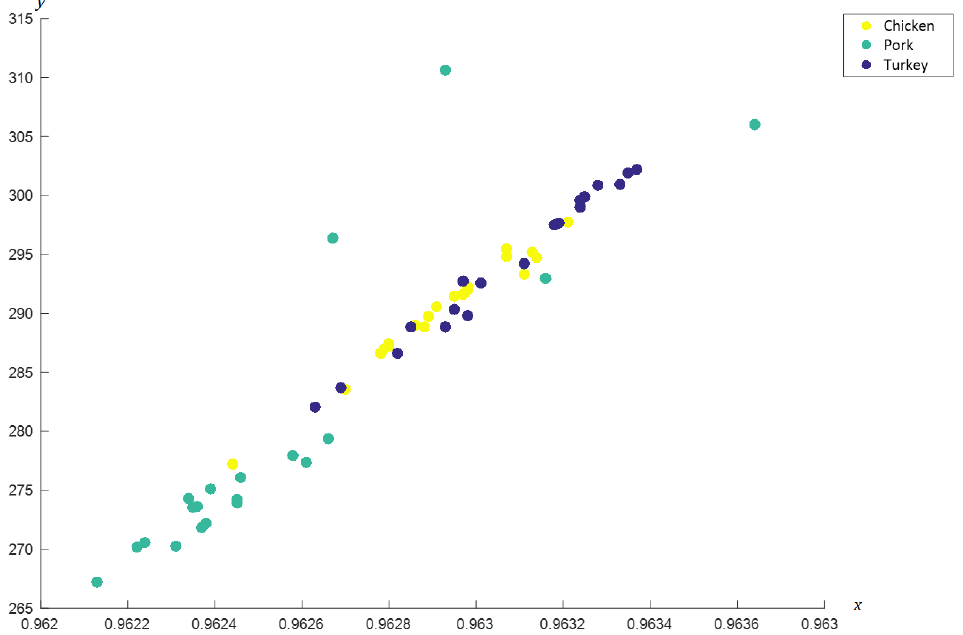
Figure 10. Coordinated FACS of chicken, pork and turkey meats.